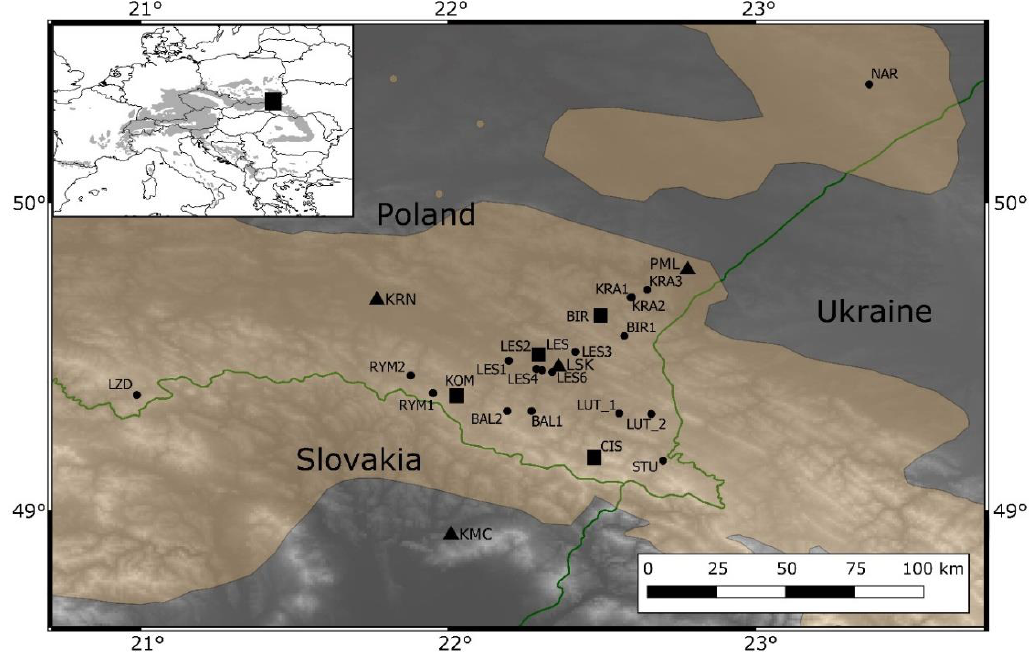
Figure 1. Locations of the experimental sites and the tested populations. Experimental sites (squares), populations (dots), and weather stations (triangles). Distribution range of silver fir (main map: in beige, upper left map: in gray) according to http://www.euforgen.org/. Experimental sites: BIR — Bircza, KOM —Komańcza, CIS— Cisna, LES — Lesko. Weather stations: PML —Przemyśl, LSK— Lesko, KRN — Krosno, KMC — Kamenica nad Cirochou. Acronyms for populations according to Table 1.